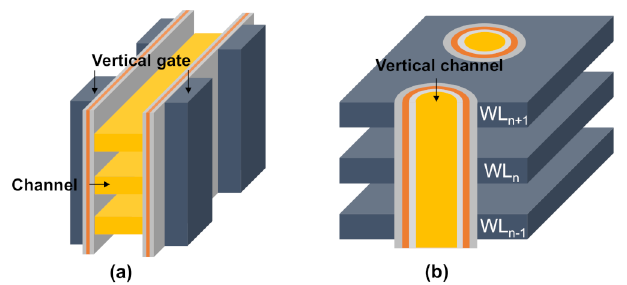
Figure 1. Schematic diagrams of 3D NAND architecture: ( a ) vertical gate and ( b ) vertical channel.